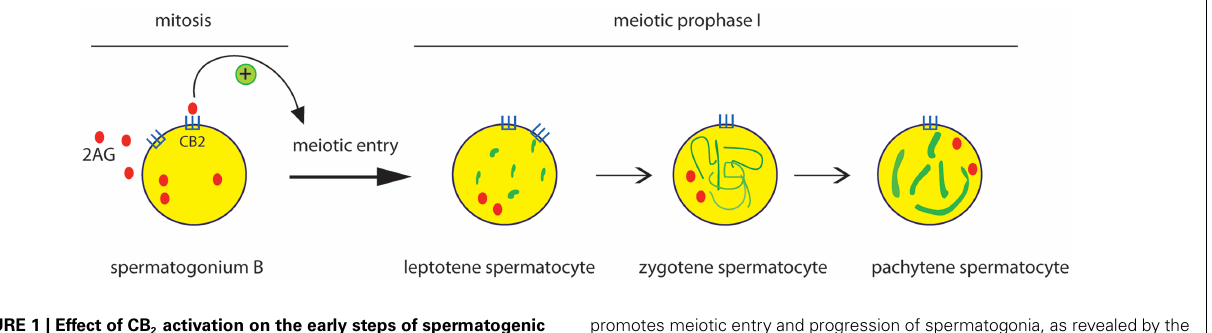
FIGURE 1 | Effect of CB 2 activation on the early steps of spermatogenic differentiation . Mitotic male germ cells express CB 2 receptor and high level of 2-AG. Activation of CB 2 receptor by 2-AG, through an autocrine pathway,